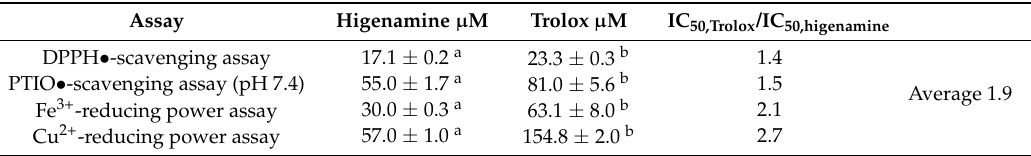
Table 1. IC 50 values of higenamine and Trolox in various antioxidant